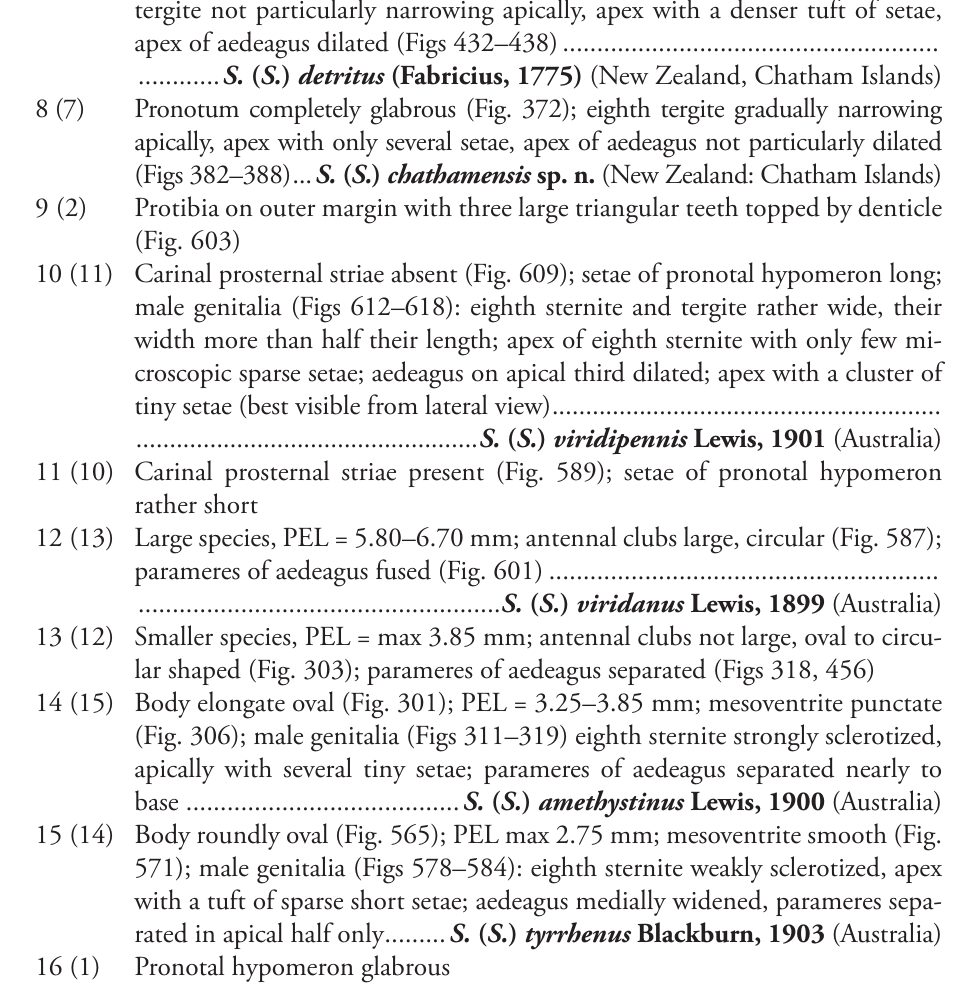
3 (4) Bi-colored species (Fig. 458), elytra usually dark blue; pronotum often metal- lic green; parameres of aedeagus widely separated on their apical half (Fig. 475) ................. S. ( S. ) laetus Erichson, 1834 (Australia, Lord Howe Island) 4 (3) Unicolored, castaneous to dark brown species without metallic luster (Fig. 511); parameres of aedeagus not widely separated (Fig. 526) (New Zealand and Chatham Islands species) 5 (6) Dorsum matte, with alutaceous microsculpture, apical third of elytra with aciculate punctures (Figs 511, 515) ............................................................... .................... S. ( S. ) pseudodetritus sp. n. (New Zealand: Chatham Islands) 6 (5) Dorsum shining, with punctures but never with alutaceous microsculpture, apical third of elytra with simple, not aciculate punctures (Figs 372, 376) 7 (8) Pronotum laterally with a band of deep, dense punctures (Fig. 422); eighth tergite not particularly narrowing apically, apex with a denser tuft of setae, apex of aedeagus dilated (Figs 432–438) ....................................................... ............ S. ( S. ) detritus (Fabricius, 1775) (New Zealand, Chatham Islands) 8 (7) Pronotum completely glabrous (Fig. 372); eighth tergite gradually narrowing apically, apex with only several setae, apex of aedeagus not particularly dilated (Figs 382–388) ... S. ( S. ) chathamensis sp. n. (New Zealand: Chatham Islands) 9 (2) Protibia on outer margin with three large triangular teeth topped by denticle (Fig. 603) 10 (11) Carinal prosternal striae absent (Fig. 609); setae of pronotal hypomeron long; male genitalia (Figs 612–618): eighth sternite and tergite rather wide, their width more than half their length; apex of eighth sternite with only few mi- croscopic sparse setae; aedeagus on apical third dilated; apex with a cluster of tiny setae (best visible from lateral view) .......................................................... ................................................... S. ( S. ) viridipennis Lewis, 1901 (Australia) 11 (10) Carinal prosternal striae present (Fig. 589); setae of pronotal hypomeron rather short 12 (13) Large species, PEL = 5.80–6.70 mm; antennal clubs large, circular (Fig. 587); parameres of aedeagus fused (Fig. 601) ......................................................... ..................................................... S. ( S. ) viridanus Lewis, 1899 (Australia) 13 (12) Smaller species, PEL = max 3.85 mm; antennal clubs not large, oval to circu- lar shaped (Fig. 303); parameres of aedeagus separated (Figs 318, 456) 14 (15) Body elongate oval (Fig. 301); PEL = 3.25–3.85 mm; mesoventrite punctate (Fig. 306); male genitalia (Figs 311–319) eighth sternite strongly sclerotized, apically with several tiny setae; parameres of aedeagus separated nearly to base ........................................ S. ( S. ) amethystinus Lewis, 1900 (Australia) 15 (14) Body roundly oval (Fig. 565); PEL max 2.75 mm; mesoventrite smooth (Fig. 571); male genitalia (Figs 578–584): eighth sternite weakly sclerotized, apex with a tuft of sparse short setae; aedeagus medially widened, parameres sepa- rated in apical half only ......... S. ( S. ) tyrrhenus Blackburn, 1903 (Australia) 16 (1) Pronotal hypomeron